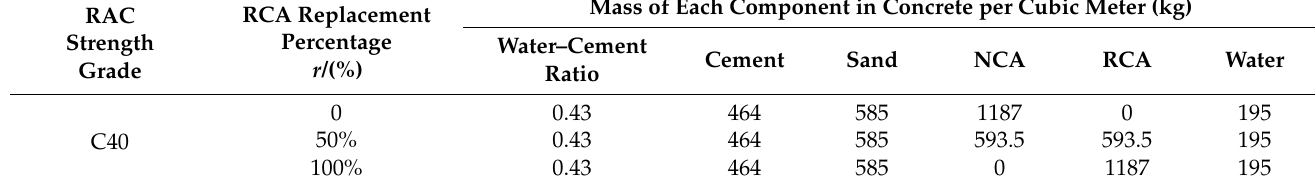
Table 3. Design parameters of joint specimens.